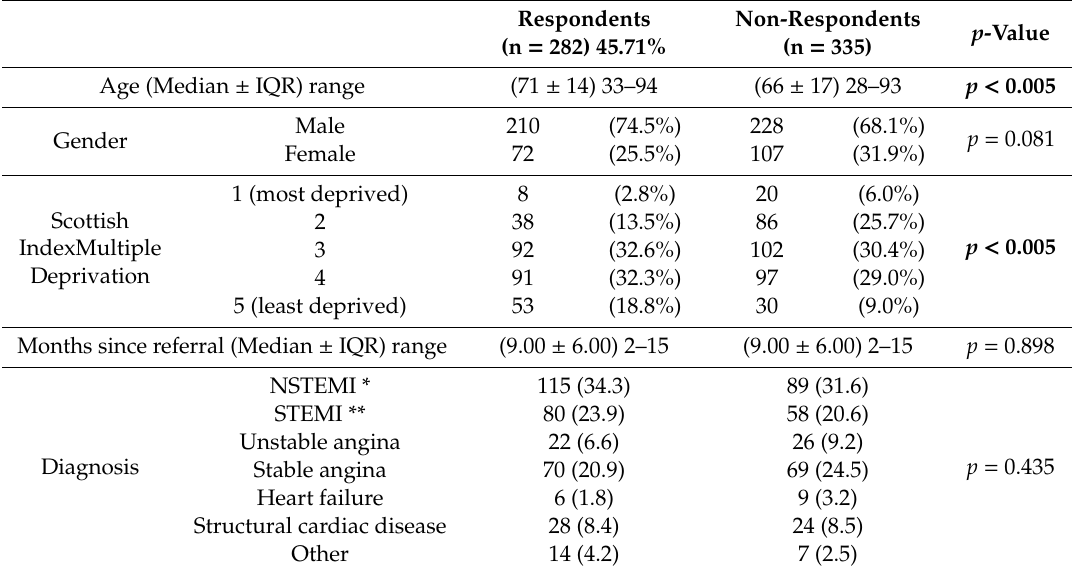
Table 1. Baseline population characteristics.